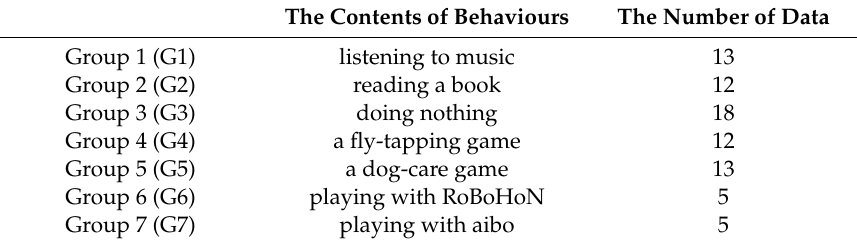
Table 1. The behaviours during the breaks and number of data in each